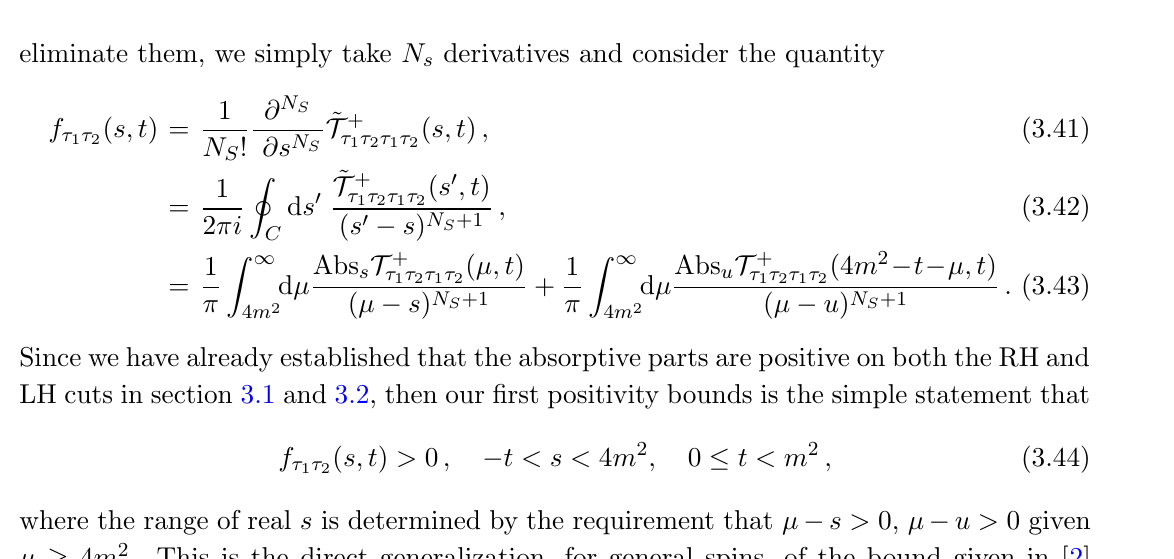
Figure 2 . The scattering amplitude can be analytically continued to the entire complex s plane, with the poles at s = m 2 and 3 m 2 (cid:0) t and branch cuts along the real axis from (cid:0) t to (cid:0)1 and from 4 m 2 to 1